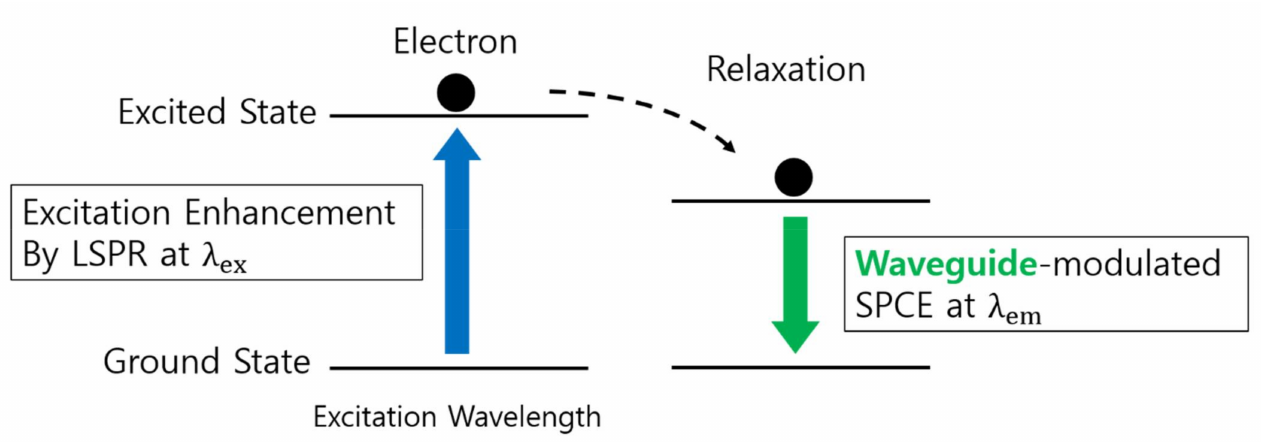
Figure 7. The dual coupling of dye molecules with the metal nanostructures, i.e., AgNPs, and the 50 nm-thick Ag film at two distinct wavelengths, λ ex , and λ em .